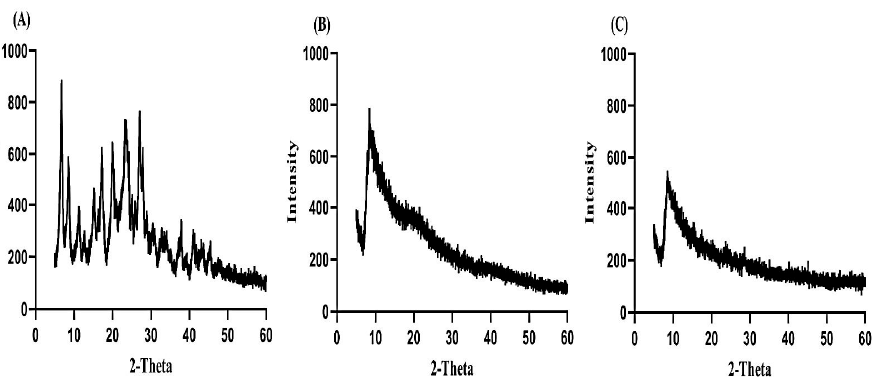
Figure 6. XRD of ( A ) DS, ( B ) unloaded SA-co-poly(AMPS) hydrogel, ( C ) loaded SA-co-poly(AMPS) Figure 6. XRD of (A) DS, (B) unloaded SA ‐ co ‐ poly(AMPS) hydrogel, (C) loaded SA ‐ co ‐ hydrogel. poly(AMPS) hydrogel